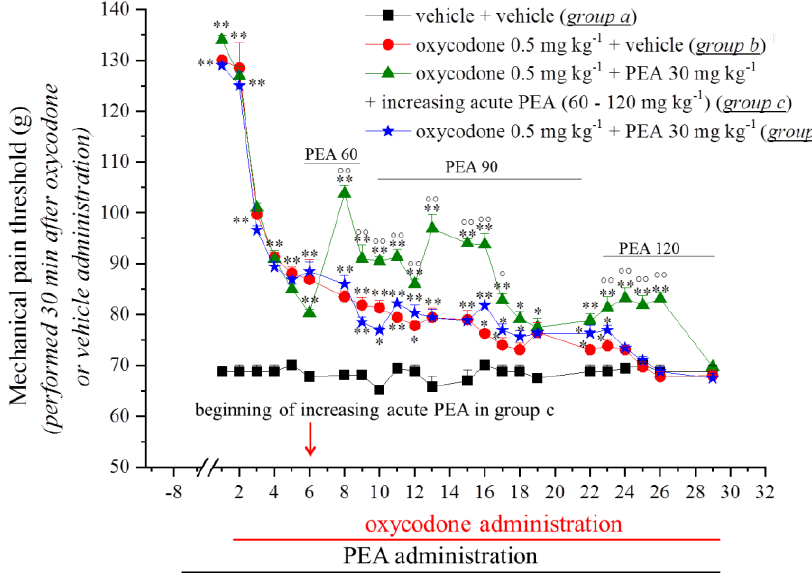
Figure 1. Effect of repeated administration of PEA on the onset of oxycodone tolerance and analgesia. Pre-emptive PEA (30 mg kg − 1 ; Groups c and d) or the vehicle (Groups a and b) was orally administered daily (in the evening) for the duration of the experiment, starting on Day − 8. On Day 1, daily, acute oxycodone treatment (0.5 mg kg − 1 s.c.) started. From Day 6, Group c received an additional acute daily PEA treatment (60–120 mg kg − 1 ) in co-administration with the opioid. The pain threshold measurements (paw pressure test) were conducted in the morning, 16 h after pre-emptive PEA administration and 30 min after oxycodone injection. The results are expressed as the mean ± S.E.M. of values from 12 rats analysed in two different experimental sets. Statistical analysis was one-way ANOVA followed by Bonferroni’s post hoc comparison. * p < 0.05 and ** p < 0.01 vs. vehicle + vehicle; ◦ p < 0.05 and ◦◦ p < 0.01 vs. oxycodone + vehicle.